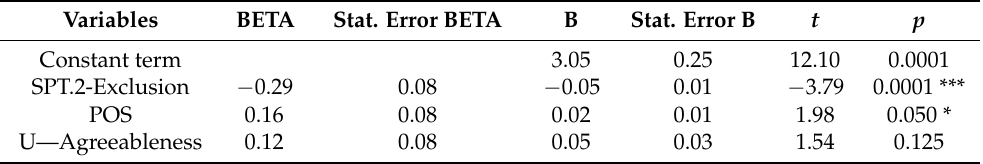
Table 9. Determinants of the ‘instrumental support’ variable.